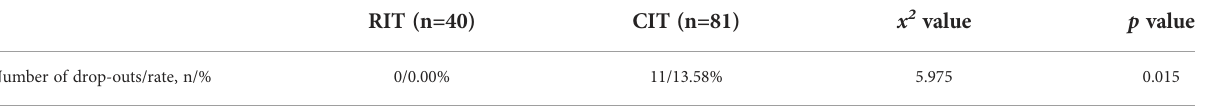
TABLE 6 Patient compliance in the RIT and CIT groups.